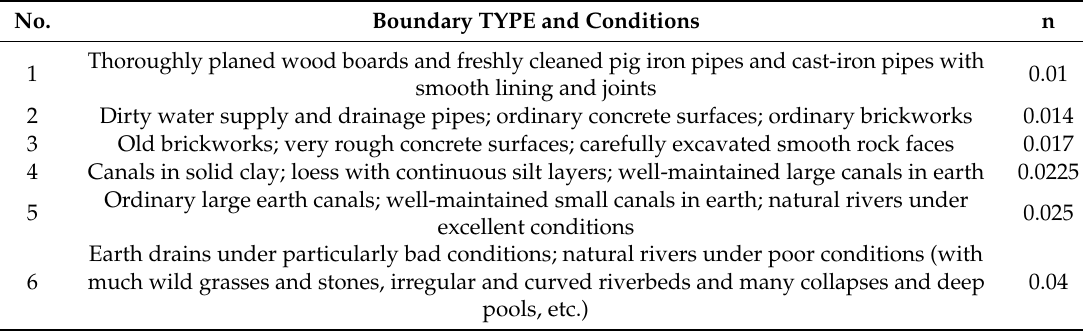
Table 2. Roughness coe ffi cients table